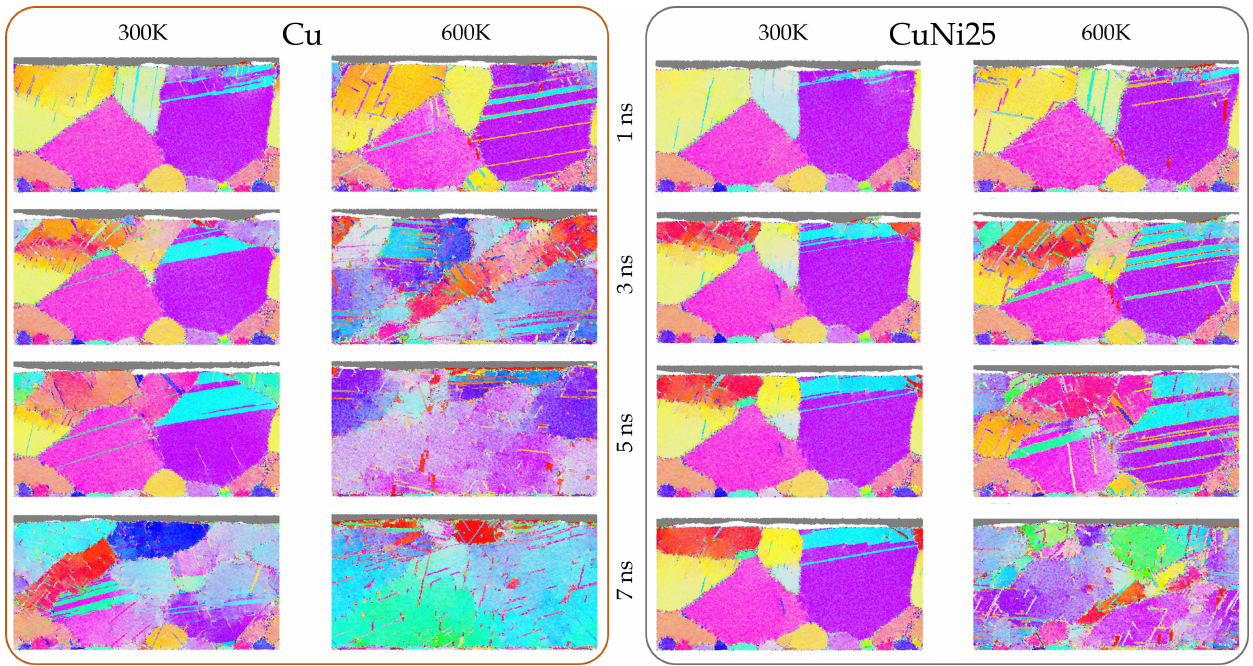
Figure 2. Time evolution of a representative EBSD tomographic section (85 nm × 40 nm) at constant normal pressure of 0.4 GPa. From left to right column: Cu at 300 K, Cu at 600 K, CuNi25 at 300 K, CuNi25 at 600 K. The EBSD tomograph corresponding to the undeformed system as well as the EBSD color legend are shown in the bottom right of Figure